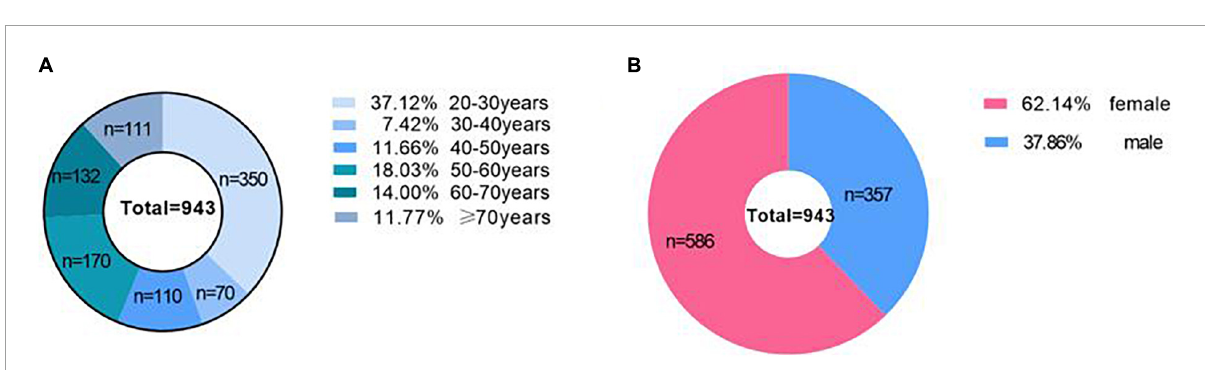
FIGURE2 The age range and sex distribution of subjects. (A) Shows the age range of subjects, and (B) shows the sex distribution of subjects.